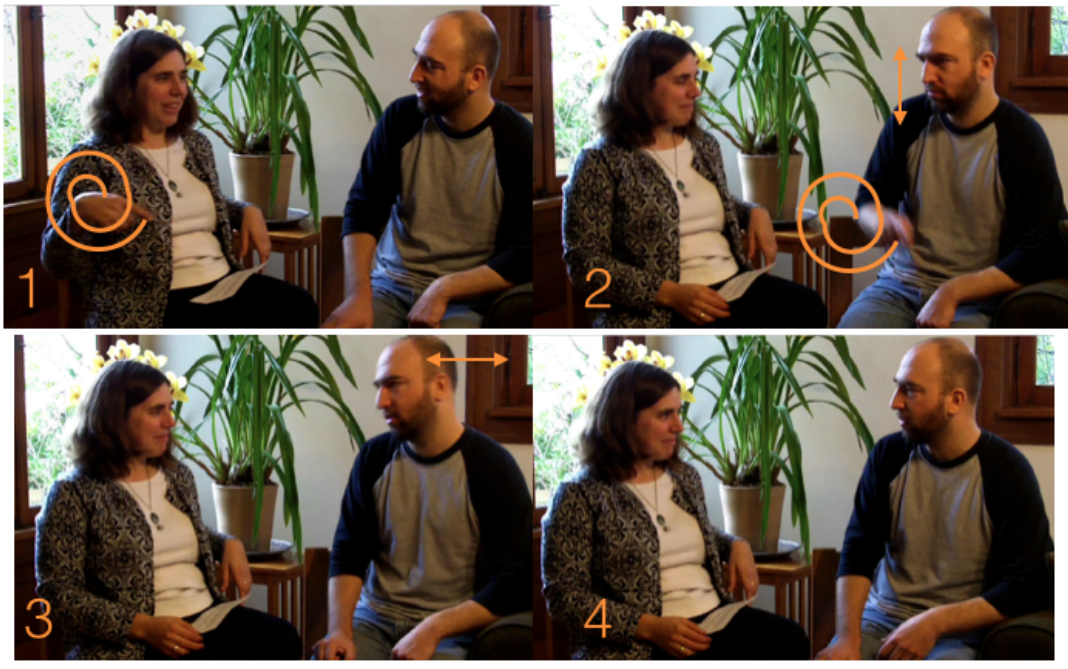
Figure 1: Stills from Mirrors